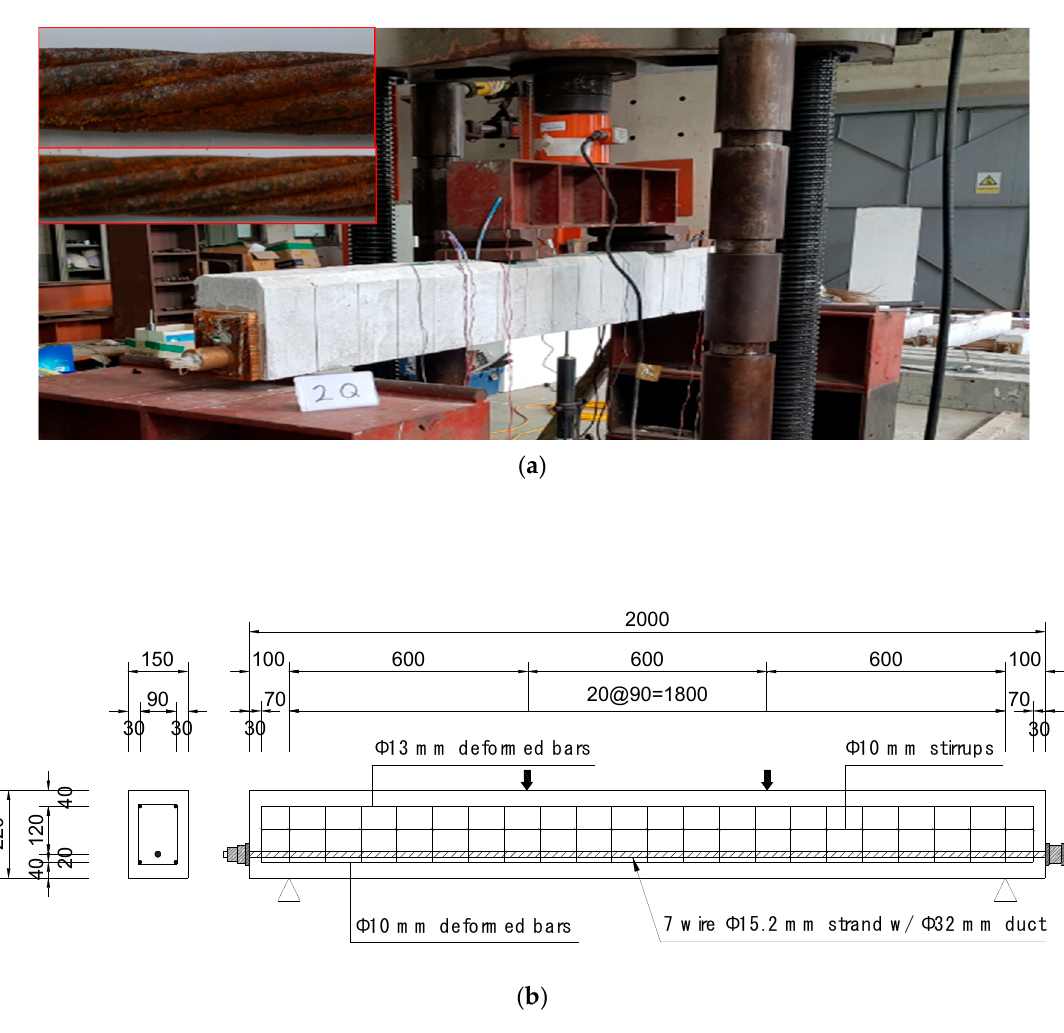
Figure 15. ( a ) Test setup and ( b ) detail drawing. Table 2. Beam test specimens.